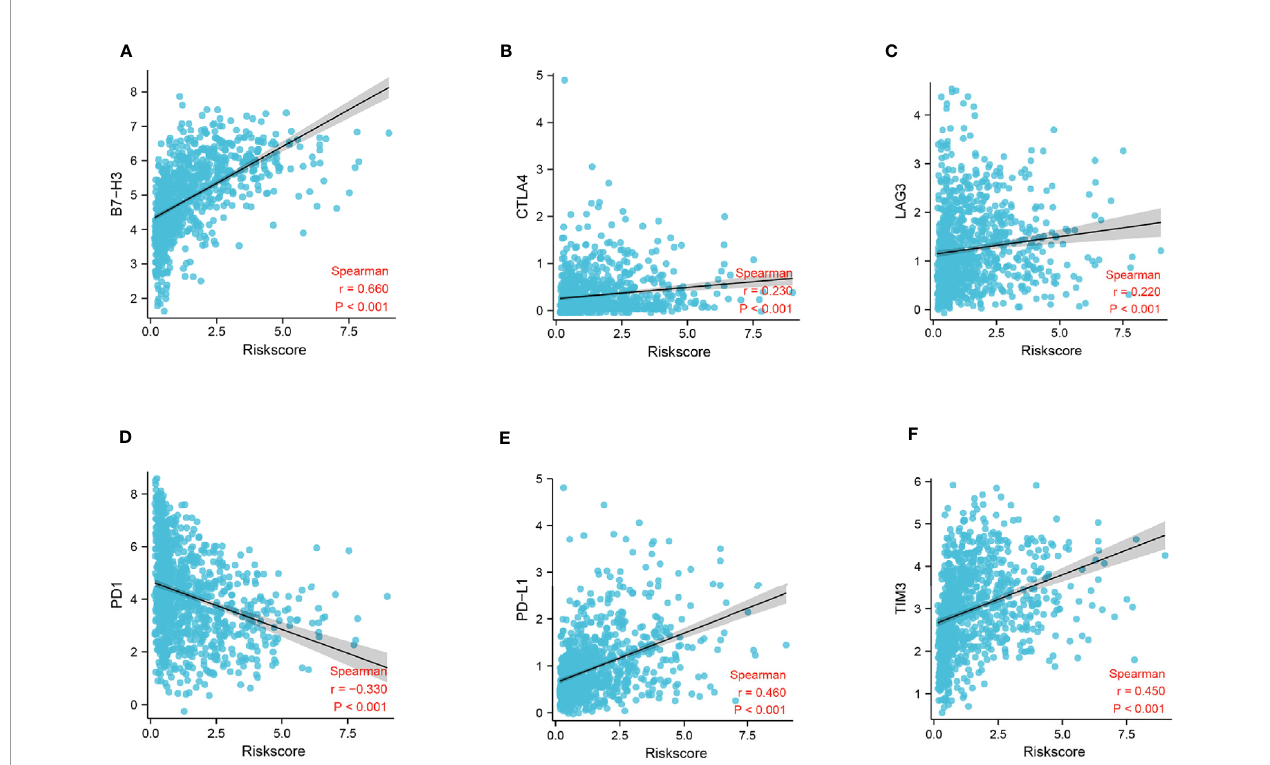
FIGURE 9 | Correlation analysis of risk score and immune checkpoints. (A) Correlation analysis of risk score and B7-H3 levels. (B) Correlation analysis of risk score and CTLA4 levels. (C) Correlation analysis of risk score and LAG3 levels. (D) Correlation analysis of risk score and gene PD-1 levels. (E) Correlation analysis of risk score and PD-L1 levels. (F) Correlation analysis of risk score and gene TIM3